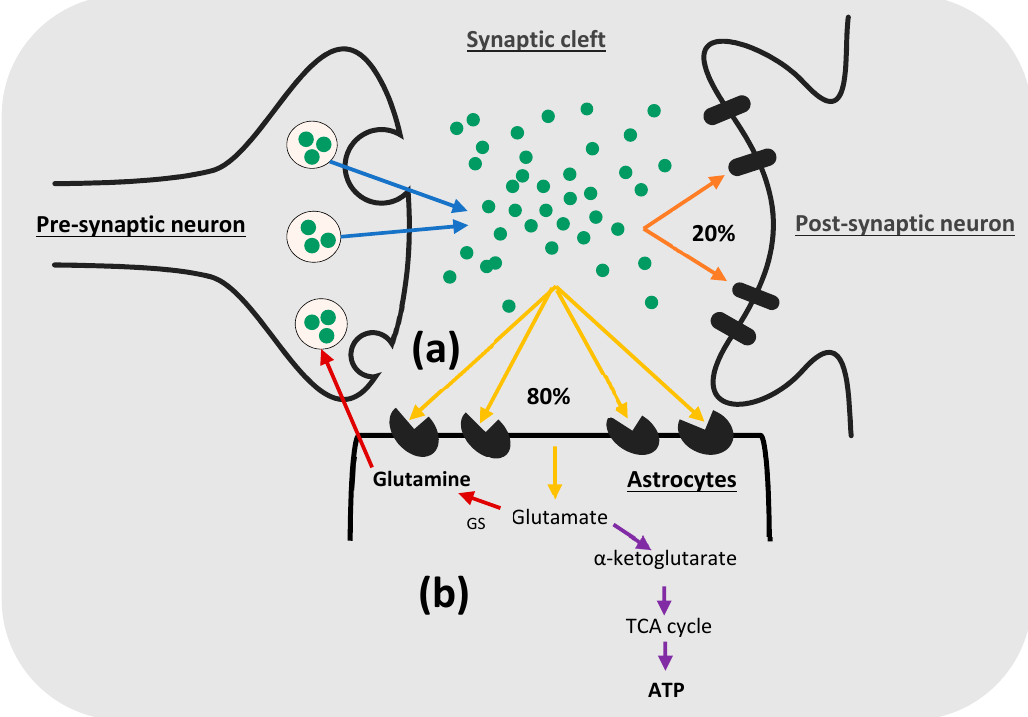
Figure 1. Glutamate uptake and metabolism by astrocytes: ( a ) Glutamate uptake by astrocytes: After release of glutamate from the presynaptic neurons (blue arrows), only 20% of glutamate is taken up by post-synaptic glutamate receptors to transmit excitatory impulses (orange arrows), while astrocytes uptake most of the remaining glutamate by their glutamate uptake transporters, EAAT-1 and EAAT-2 (yellow arrows), which are expressed on the surface of the astrocytic peri-synaptic processes; ( b ) glutamate metabolism in astrocytes: In astrocytes, glutamate could be metabolized to glutamine by glutamine synthetase (GS) (red arrows), then glutamine is released to the extracellular space to be taken up by neurons and used to resynthesize glutamate or GABA. On the other hand, glutamate could be oxidatively metabolized to α -ketoglutarate, which is used in ATP synthesis (violet arrows).